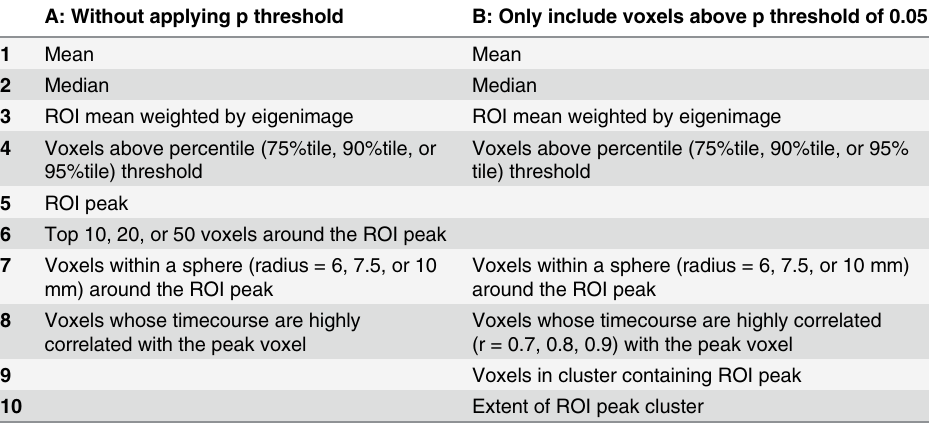
Table 1. The methods for extracting values from an ROI. A: Without applying p threshold B: Only include voxels above p threshold of